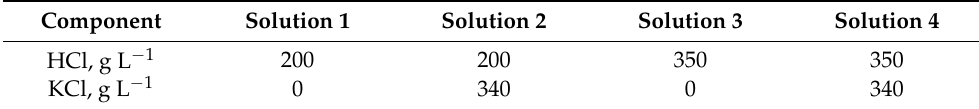
Table 1. Compositions of solutions for electrochemical studies. Component